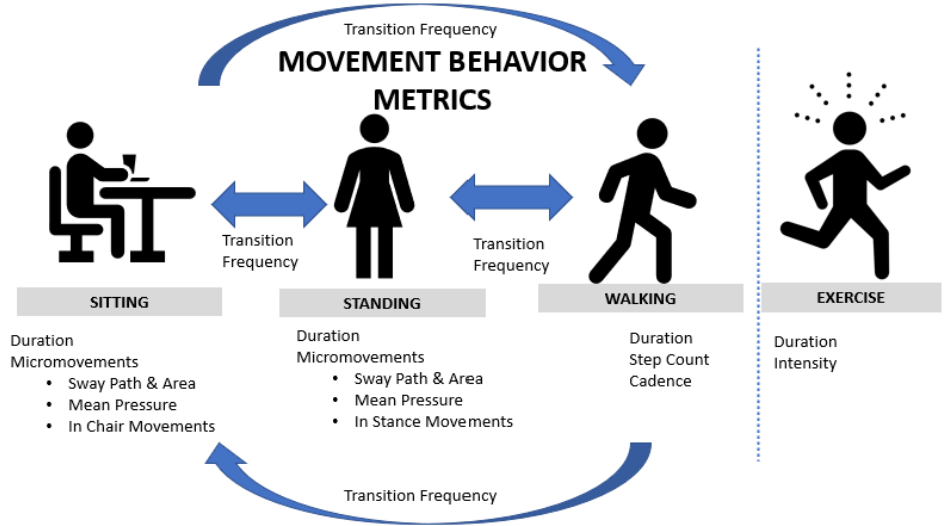
Figure 2. Revised comprehensive Movement Behavior Model that describes the different opportu- nities for movement throughout work and leisure time for sedentary office